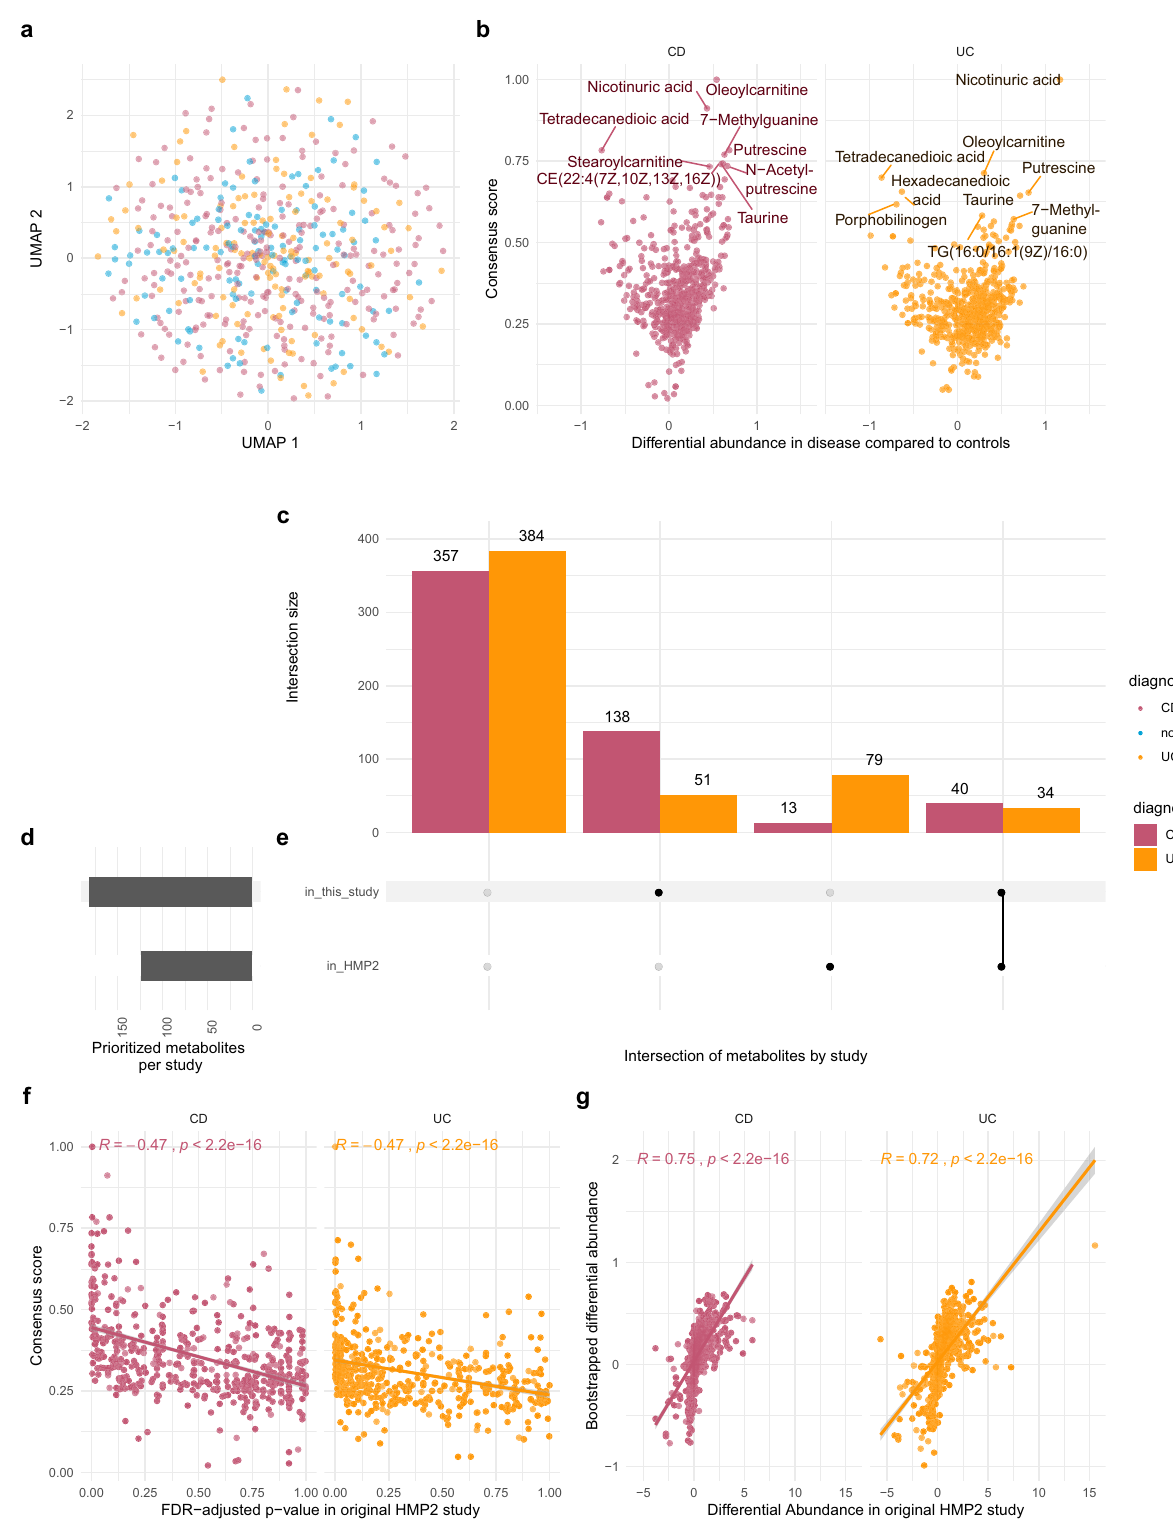
Fig. 1 Metabolomics results and comparisons to the original HMP2 IBD study 9 (HMP2). a UMAP analysis of the metabolomics sample distribution by Crohn ’ s disease (CD) and Ulcerative Colitis (UC) patients and controls (nonIBD). b Volcano plot showing the differential abundance of each metabolite per disease state against the consensus scoring of each state. c Number of metabolites considered relevant in HMP2 and current study per disease state, subdivided into overlapping and non-overlapping subsets. d Total number of metabolites selected relevant in each study. e Intersection matrix between metabolites selected each study. f Correlation plot between the bootstrapped power estimation method used to determine metabolite differential abundance between CD and UC patients results. g Correlation between the consensus scoring used in this study and HMP2 FDR-adjusted p values for each metabolite (refer to Table 1 for samples